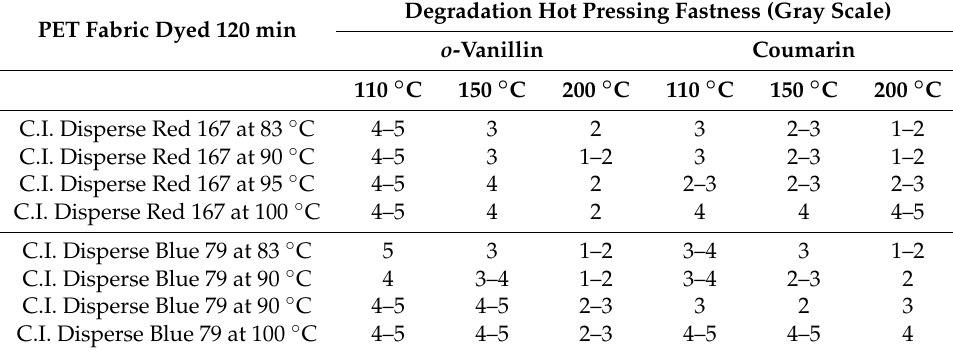
Table 9. Discharge Hot Pressing